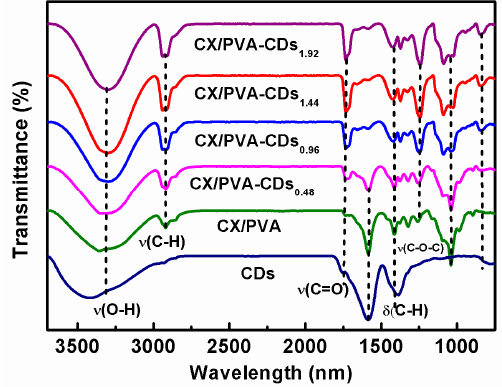
Figure 3. FT-IR spectra of CDs, CX/PVA, and CX/PVA-CDs.